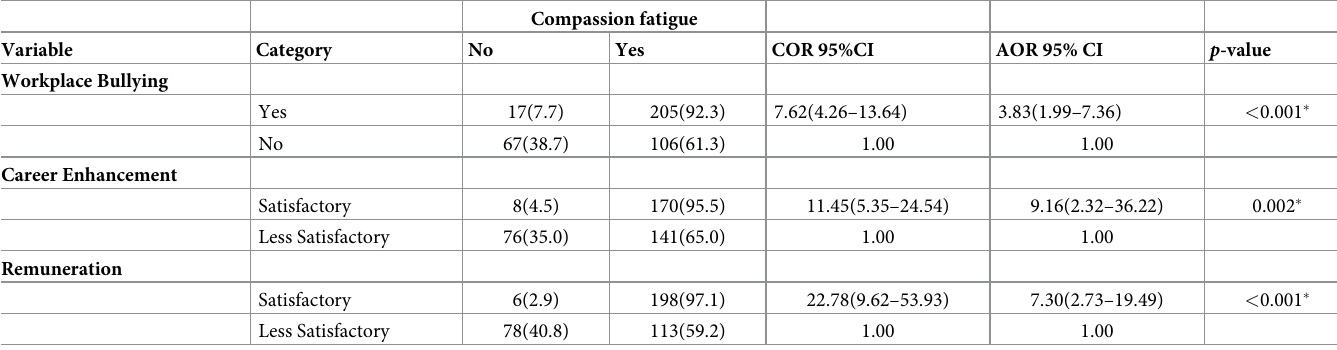
Table 4. Multivariable logistic regression analysis of predictors of compassion fatigue among nurses in Northern Uganda (N =